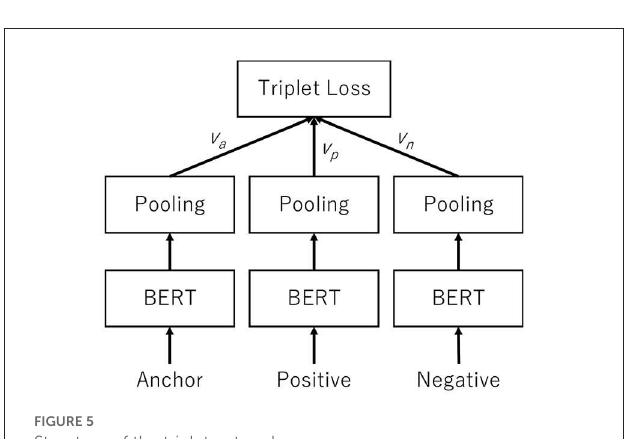
FIGURE5 Structure of the triplet network.